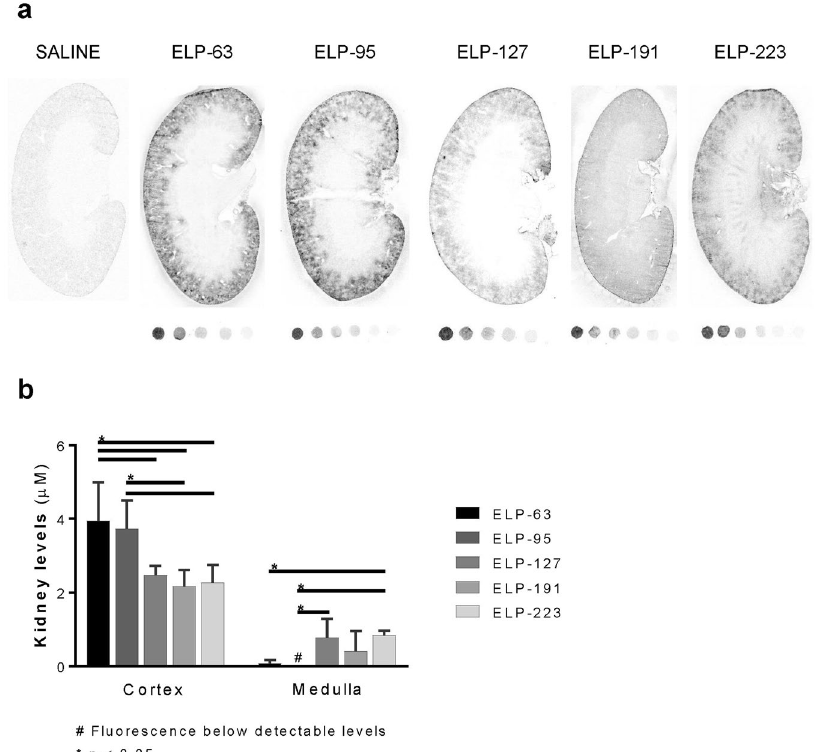
Figure 5. Quantitative Analysis of ELP Intrarenal Levels. Kidney ELP levels four hours after administration. ( a ) Fluorescence slide scans of the whole kidney section. ( b ) ELP levels in the cortex and medulla of the kidney sections as determined by quantitative fluorescence histology. Values are means ± SD, n = 4. * Statistically significant difference between indicated groups as assessed by a one-way ANOVA with post hoc Tukey’s multiple comparison, p ≤ 0.05. # Polypeptide levels below detectable